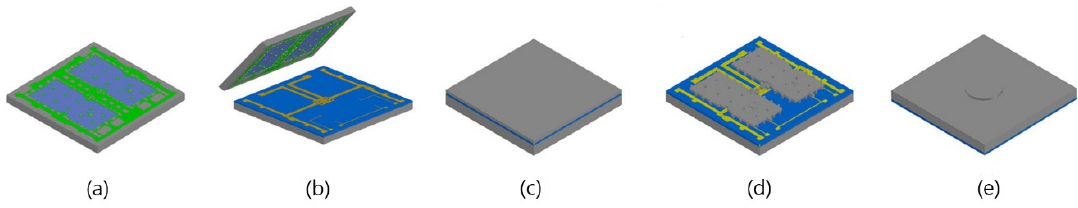
Figure 5. Chip Fabrication Process for Type I Device: ( a ) anchor formation; ( b ) electrode patterning and anodic bonding; ( c ) silicon thinning by grinding and chemical mechanical planarization (CMP); ( d ) detailed structure formation; and ( e ) pillar formation by deep reactive ion etching (DRIE).